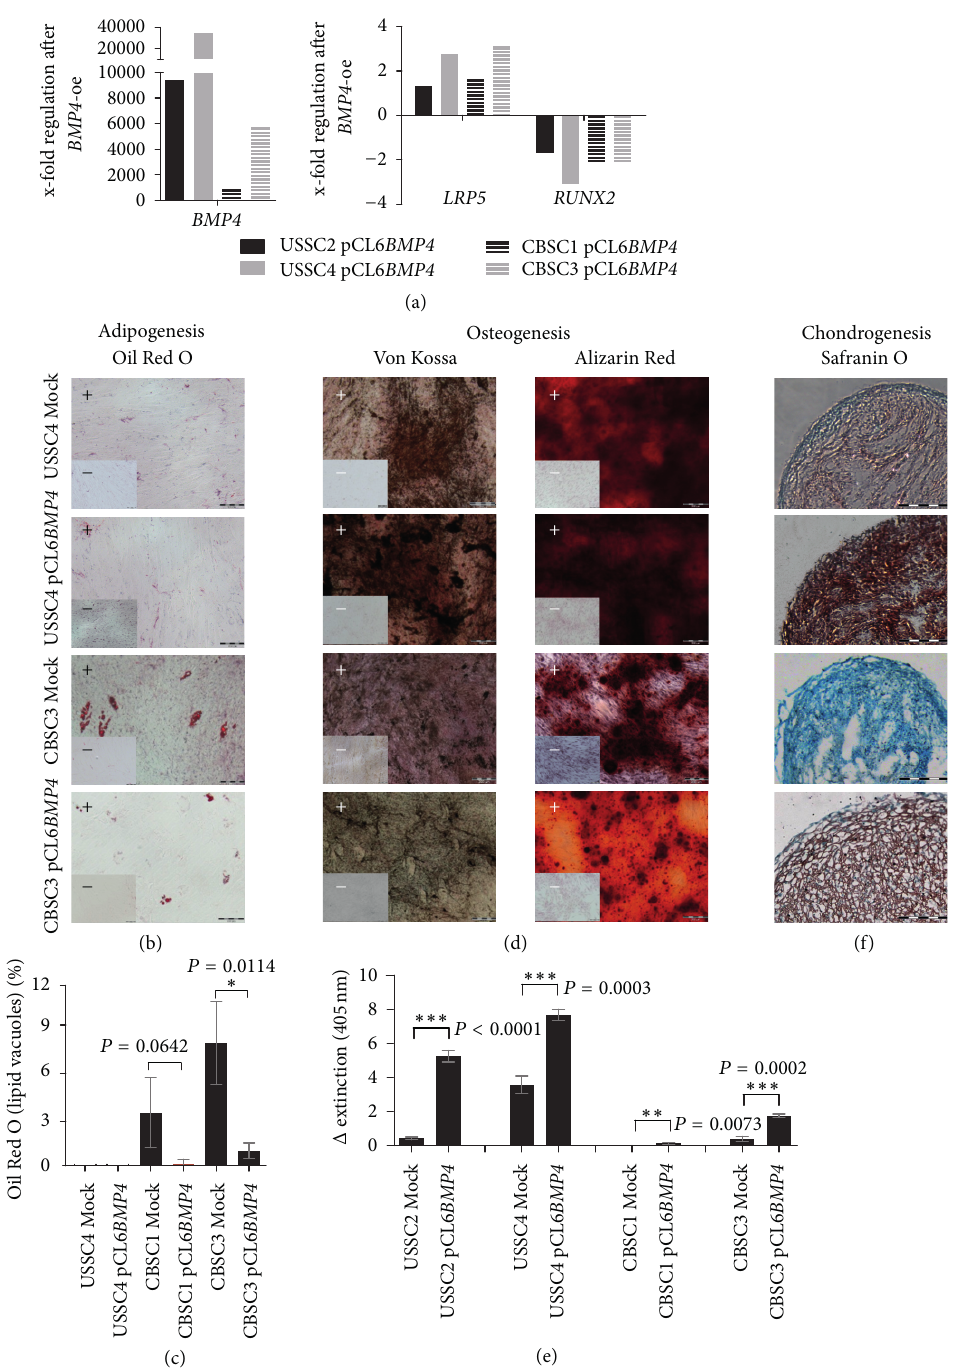
Figure 5: Lentiviral overexpression of BMP4 in two USSC and two CBSC cell lines. With regard to the staining, only one representative cell line per cell type is shown. (a) Quantitative RT-PCR analysis of gene expression (in undifferentiated cells) after overexpression in relation to the control cells (Mock). RPL13A was used as housekeeping gene. (b): Representative illustration of the Oil Red O staining after adipogenic differentiation (21d) of BMP4- transfected and control-cells. +: induced cells; − : non-induced cells. Lipid vacuoles are stained red. Scale bar: 100 𝜇 m. (c) ImageJ-based quantification of Oil Red O staining. ∗ 𝑃 = 0.01 to 0.05, significant (unpaired 𝑡 -test). (d) Osteogenic differentiation experiments in overexpressed and Mock cells. After 14 days of differentiation, Von Kossa and Alizarin Red S staining were performed in the induced (+) and non-induced ( − ) cells. Mineralized areas are stained in brown/black or red, respectively. Scale bar: 200 𝜇 m. (e) Subsequent quantification of the bound Alizarin Red S-dye. ∗∗ 𝑃 = 0.001 to 0.005, very significant; ∗∗∗ 𝑃 < 0, 001 , extremely significant (unpaired 𝑡 - test). (f) Safranin O staining of transfected and control cells after chondrogenic differentiation in pellet culture for 21 days. Proteoglycans are stained purple/red. Scale bar: 200 𝜇 m. BMP4: bone morphogenetic protein 4, LRP5 : low-density lipoprotein receptor-related protein 5, RUNX2: runt-related transcription factor 2, and RPL13A : ribosomal protein